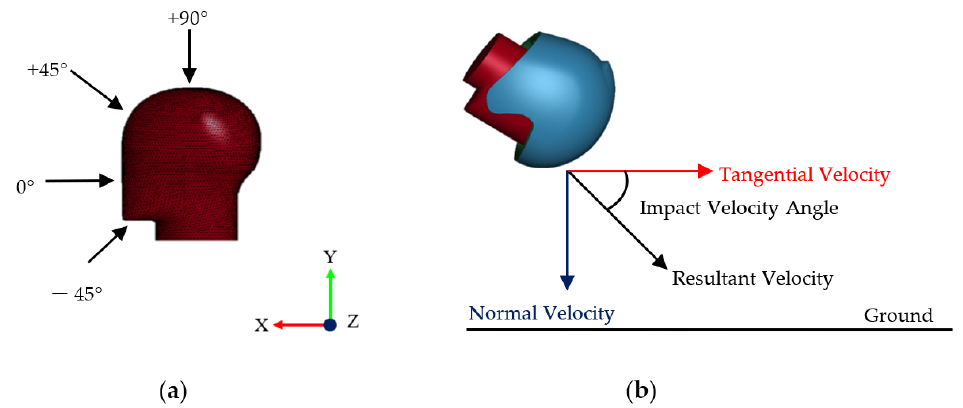
Figure 8. Angles for assigning to the model. ( a ) Head impact; ( b ) impact velocity.